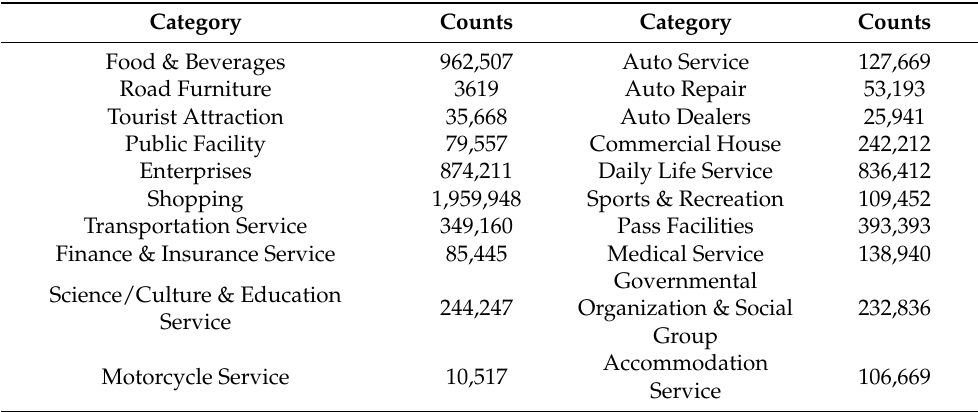
Table 2. Categories of Gaode Map